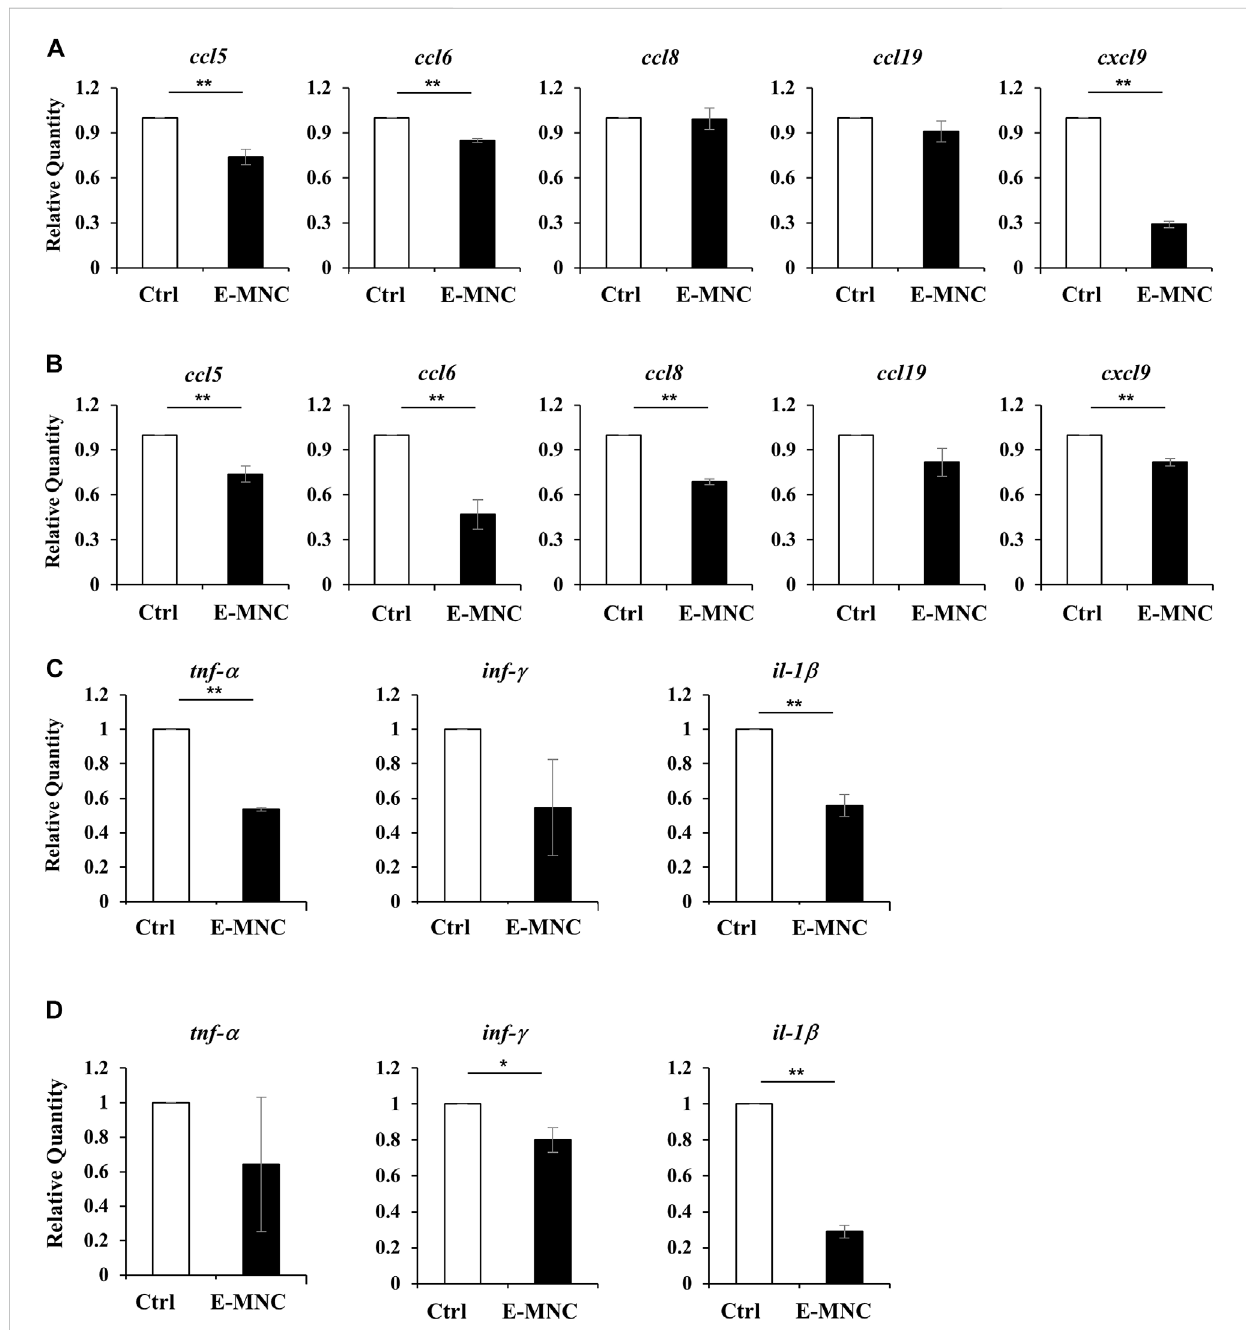
FIGURE 8 Gene expression in submandibular glands in the initial post-transplantation stage. (A,B) mRNA expression of the in fl ammatory chemokines ccl5 , ccl6 , ccl8 , ccl19 , and cxcl9 in non-treated glands (Ctrl) and E-MNC – treated glands (E-MNC) at 1 day (A) and 3 days (B) post-transplantation (** p < 0.01). (C,D) Expression of the pro-in fl ammatory genes tnf- α , inf- γ , and il-1 β in non-treated glands (Ctrl) and E-MNC – treated glands (E-MNC) at 1 day (C) and 3 days (D) post-transplantation (* p < 0.05, ** p < 0.01). For statistical analysis, the Student ’ s t-test was used to analyze differences between E-MNC- group and